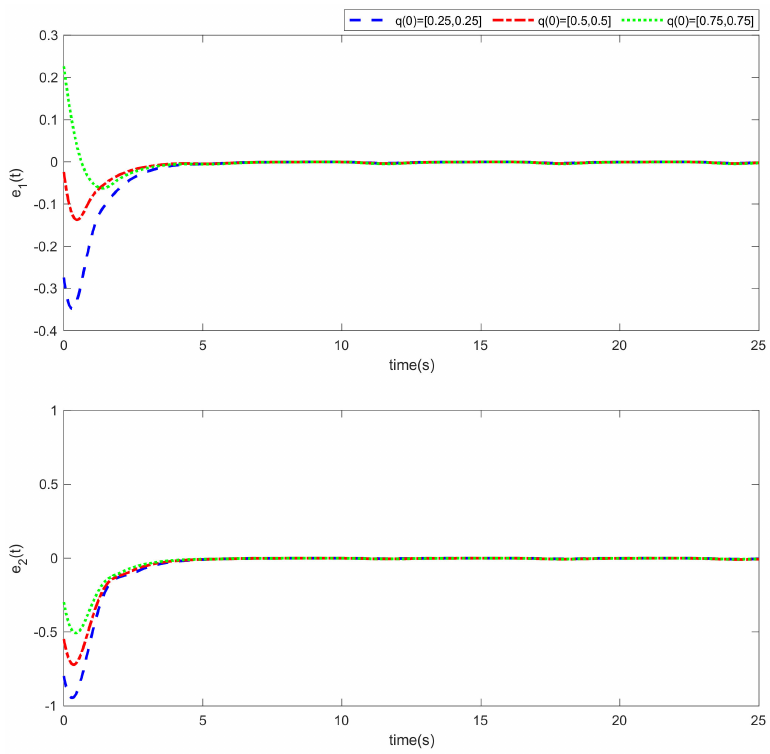
Figure 5. Time responses of the tracking error (Example 1).